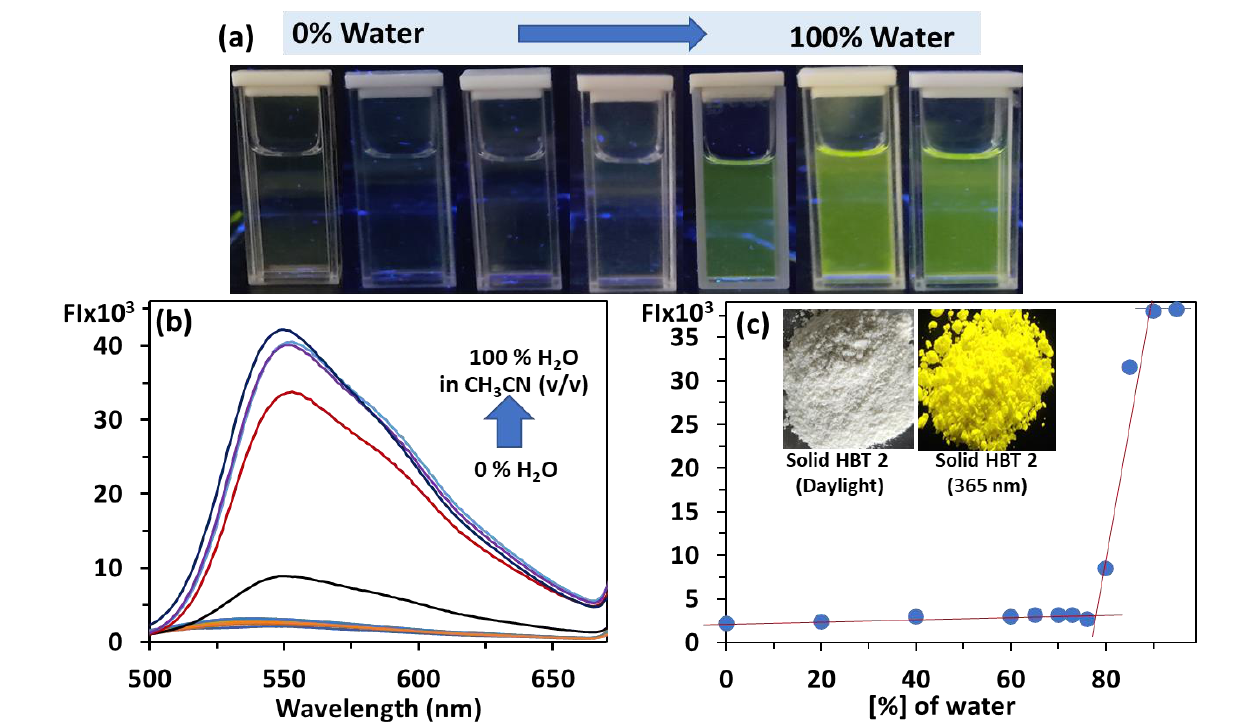
Figure 3. ( a ) Photographs (under 365 nm UV-illumination); ( b ) emission spectra (0.5 µM) of HBT 2 recorded in different fractions of water (0–100%) in CH 3 CN and ( c ) plot of fluorescence intensity versus fraction of water [inset of ( c )] photograph of HBT 2 (solid) in daylight and HBT 2 mixed with silica under 365 nm UV lamp.